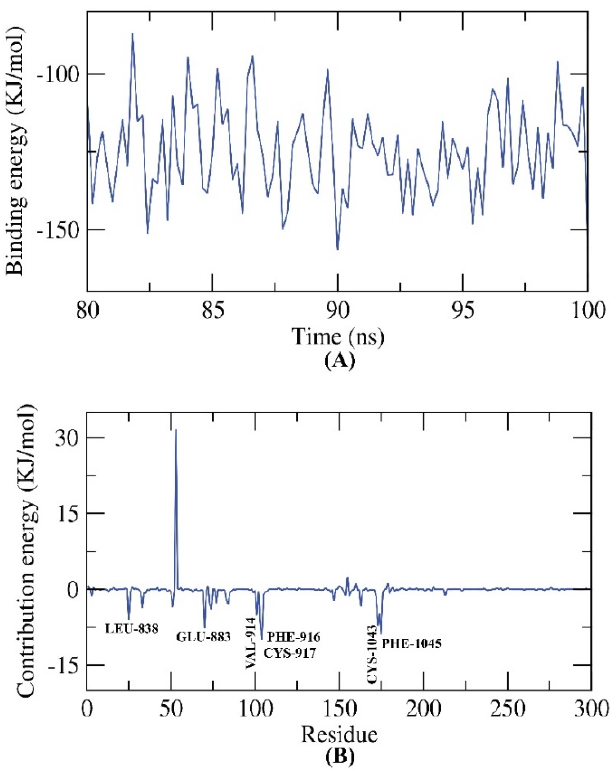
Figure 11. Finding of the MM-PBSA of compound 6-VEGFR-2 complex showing ( A ) an excellent binding free energy of − 125 KJ/mol and ( B ) the seven vital amino acids in the binding.